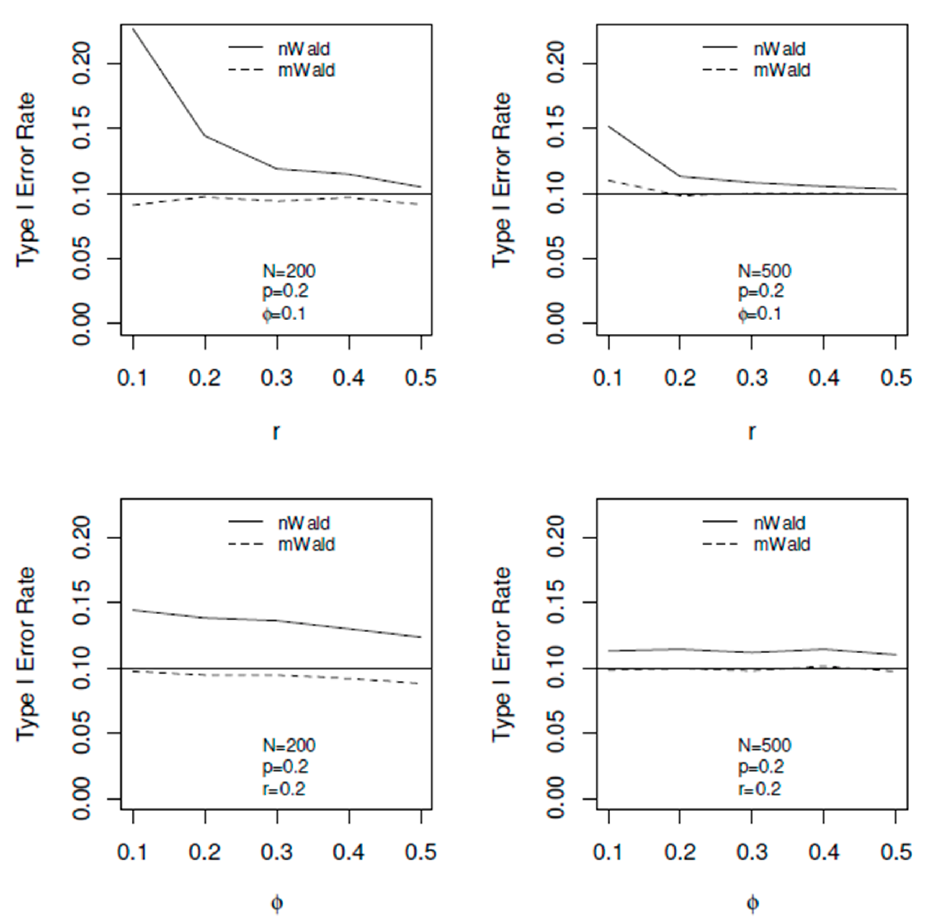
Figure 3. Type-I error rate versus r for the upper two panels and versus ϕ for the lower two